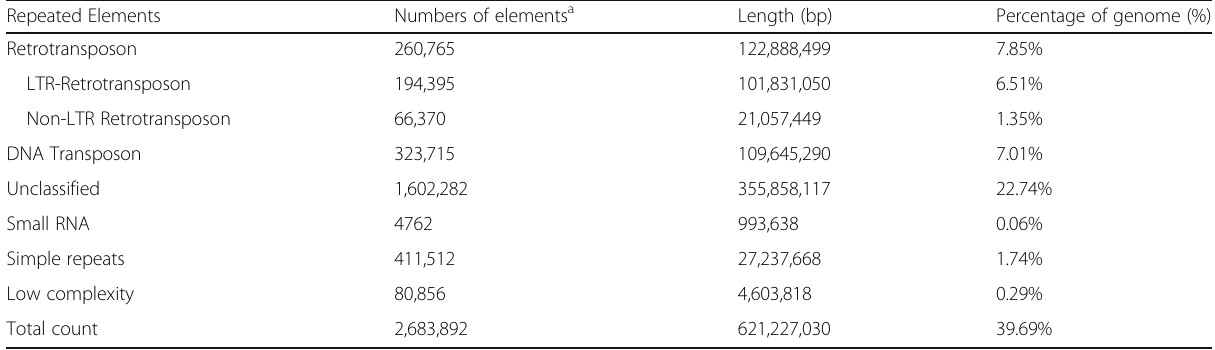
Table 4 Summary of repeated elements in D. japonica genome Repeated